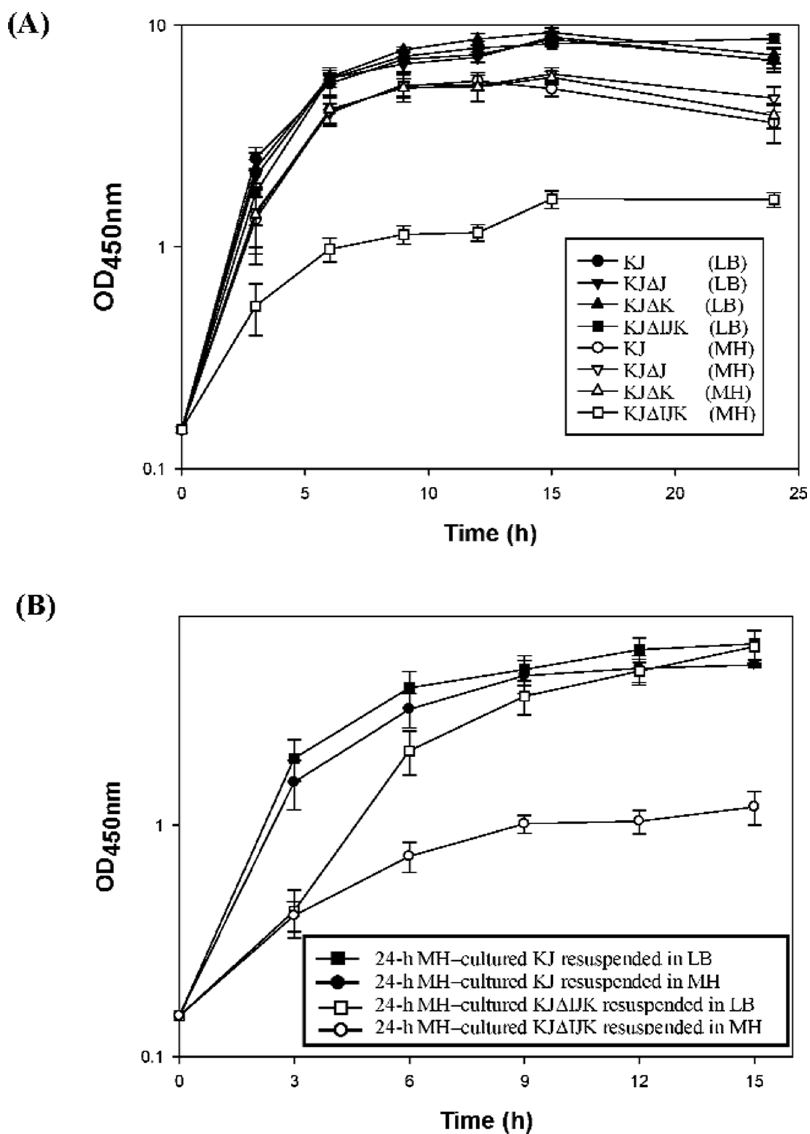
Figure 1. Growth of KJ, KJ D J, KJ D K, and KJ D IJK in Luria-Bertani (LB) and Mueller-Hinton (MH) media. (A) Growth curves of KJ, KJ D J, KJ D K, and KJ D IJK in LB and MH broth. (B) The growth curve of 24-h MH-cultured KJ and KJ D IJK cells subcultured into the MH or LB media.